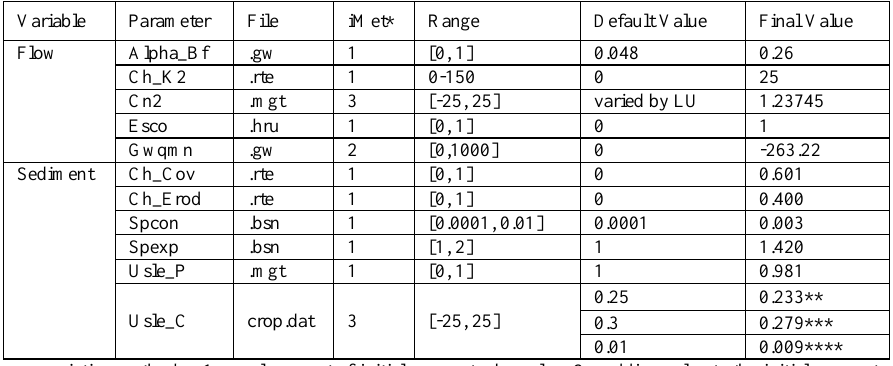
Table 3. Default and Final Values of SWAT calibration parameters for flow and sediment.